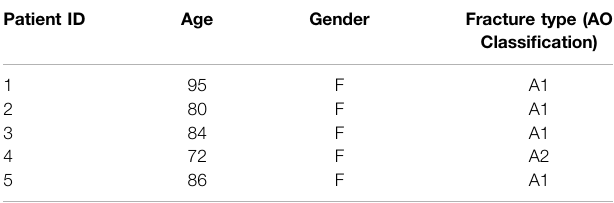
TABLE 1 | Demographic information of patients included in the TF